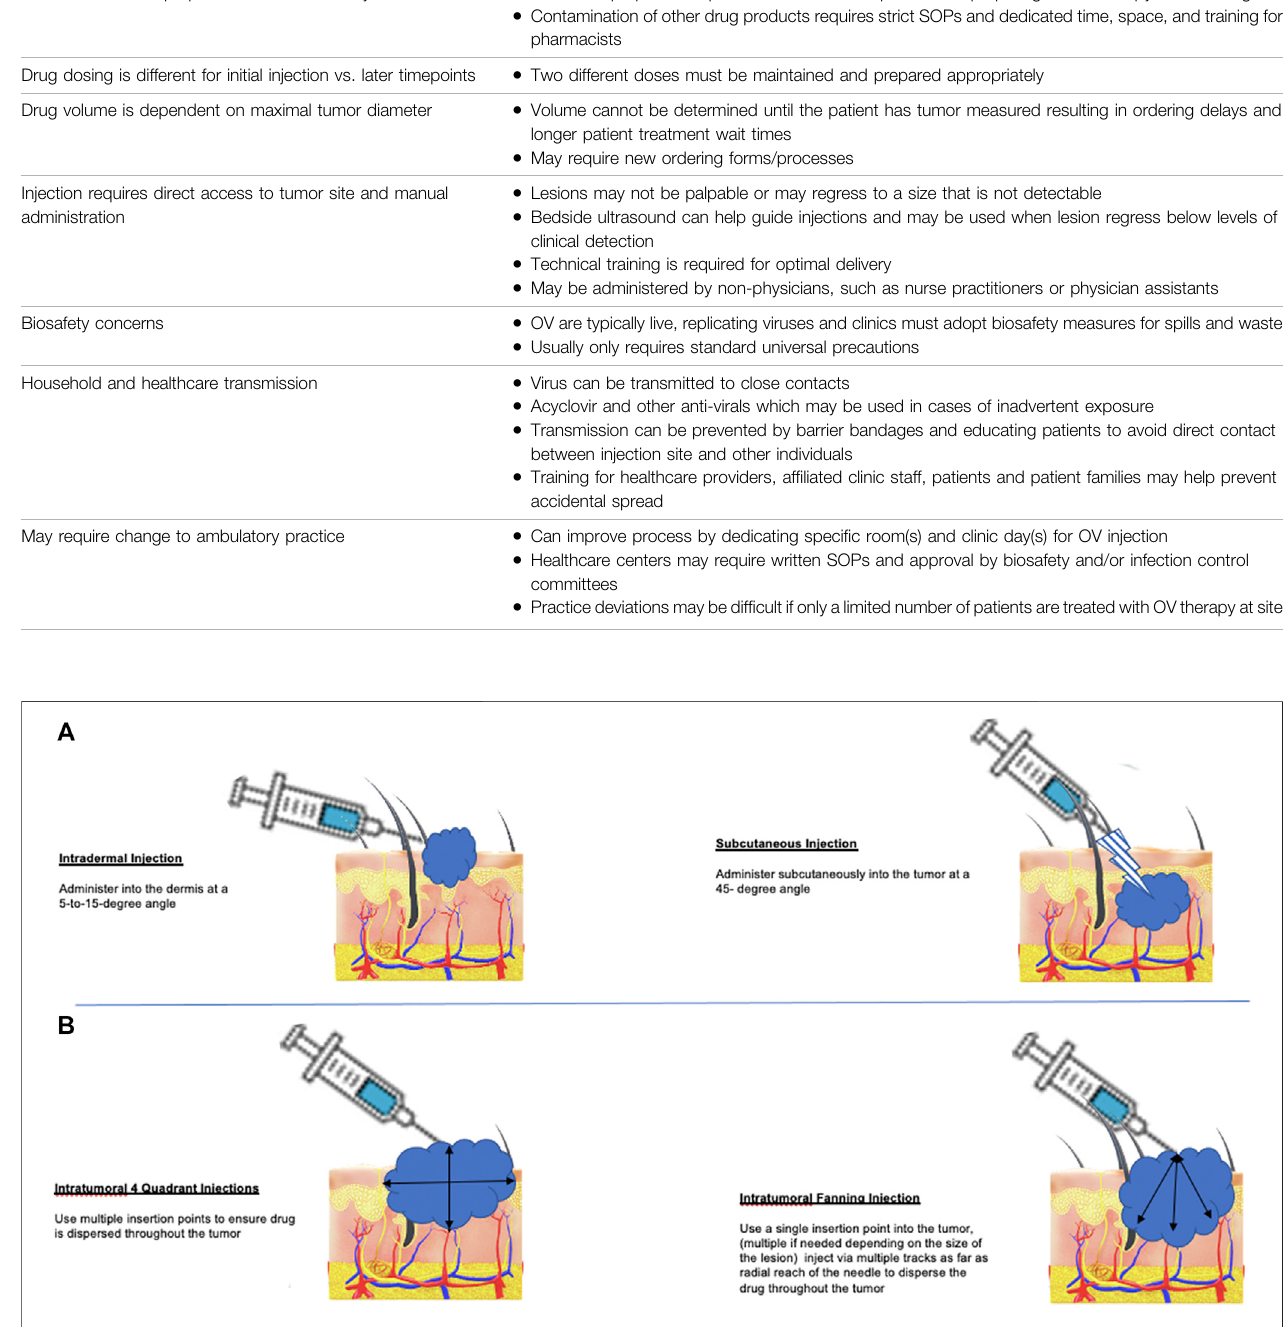
FIGURE 1 | Methods for T-VEC administration in patients with melanoma. (A) T-VEC can be administered by intradermal injection (left panel) at sites of cutaneous tumor or by subcutaneous injection (right panel) for tumors in the soft tissue or lymph nodes. If tumors are not clinically palpable or become undetectable after initiating treatment, portable ultrasound can be used to identify residual areas of tumor for injection. (B) The goal of injection is to distribute the virus as evenly as possible throughout areas ofviable tumor cells. Thiscan be done using afour-quadrant method (left panel), which allows re-insertionto reach all sites and may be preferred for large tumors; alternatively, a single injection site and then using a fan technique (right panel) for injection can also be used. In tumors with necrotic or liquid areas, peripheral injection at the edges where most viable tumor cells are located is also acceptable.